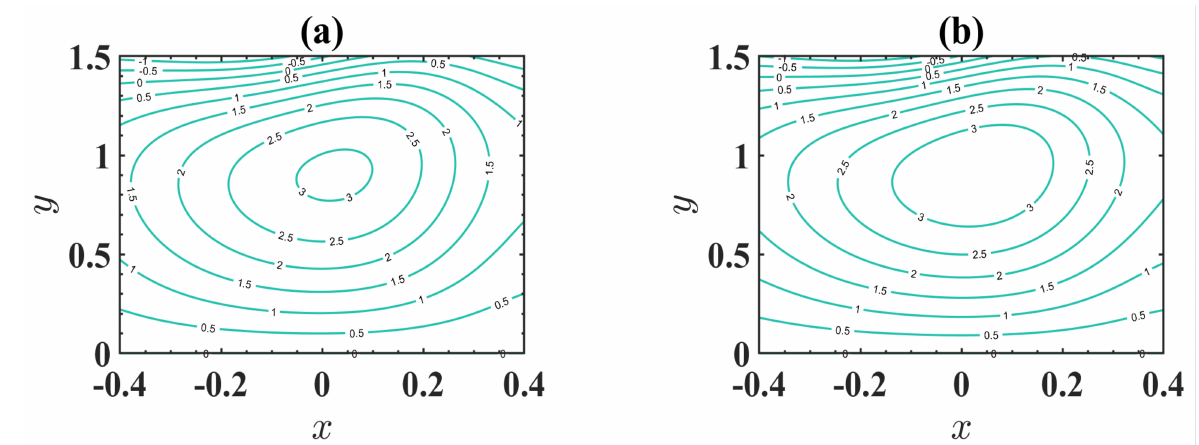
Figure 11. Streamline for varying ( a ) α = 0 and ( b ) α = π